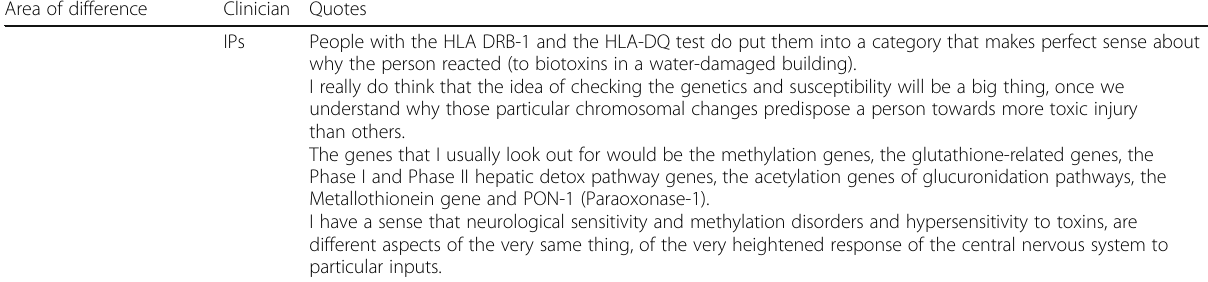
Table 1 Environmental medicine is a divided profession (Continued) Area of difference